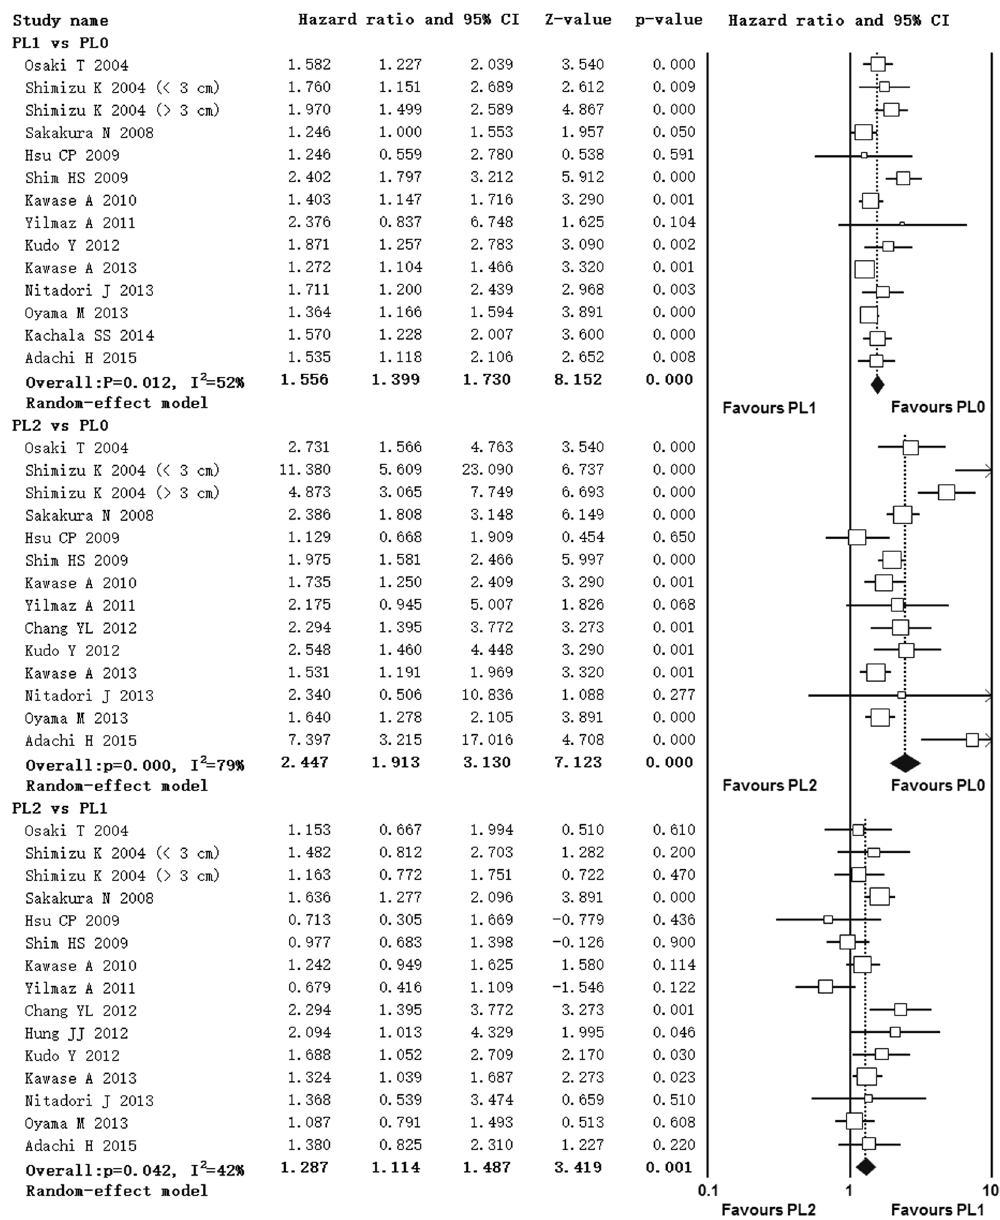
Figure 2. Forest plot showing the impact of extent of VPI on overall survival. * CI: Confidence